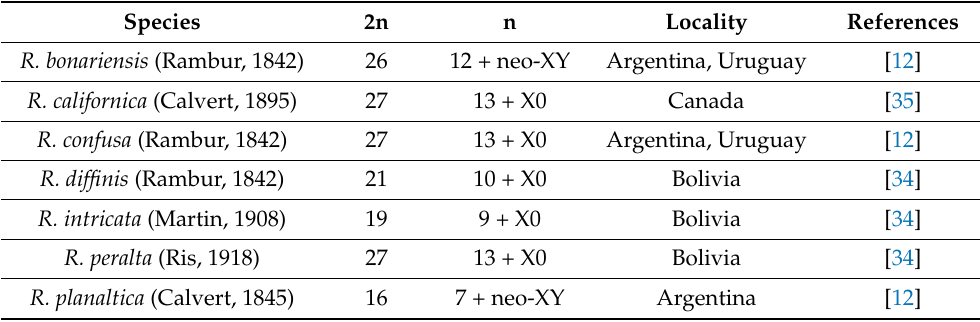
Table 1. Summary of cytogenetic data in males of Rhionaeschna species. Species 2n n